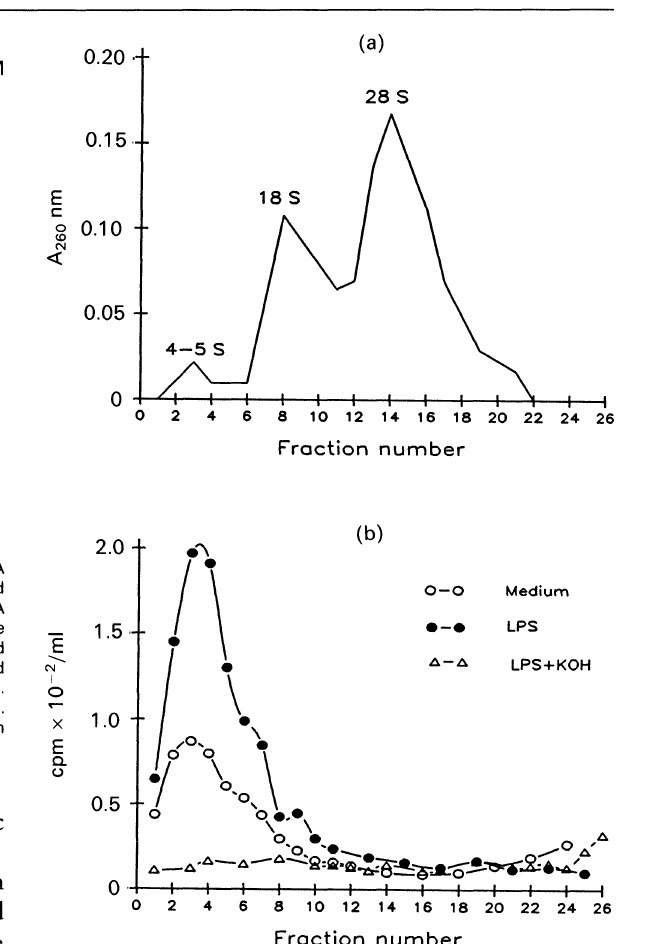
FIG. 7. Sedimentation profile of RNA secreted by normal or LPS-stimulated macrophages. Panel A: Sedimentation profile of non-radioactive RNA isolated from normal macrophages. Panel B: Sedimentation profile of R NA secreted by macrophage mortlayers either unstimulated or stimulated with LPS (10 #g/ml). The RNA secreted by LPS stimulated macrophages was also hydrolyzed with KOH before centrifugation on a 5-20% sucrose gradient. The experimental conditions are given in Materials and Methods. stimulation with LPS (10 #g/ml), IL-1/ (10 -8 M) or TNF-g (10 -8 M) was not different from that